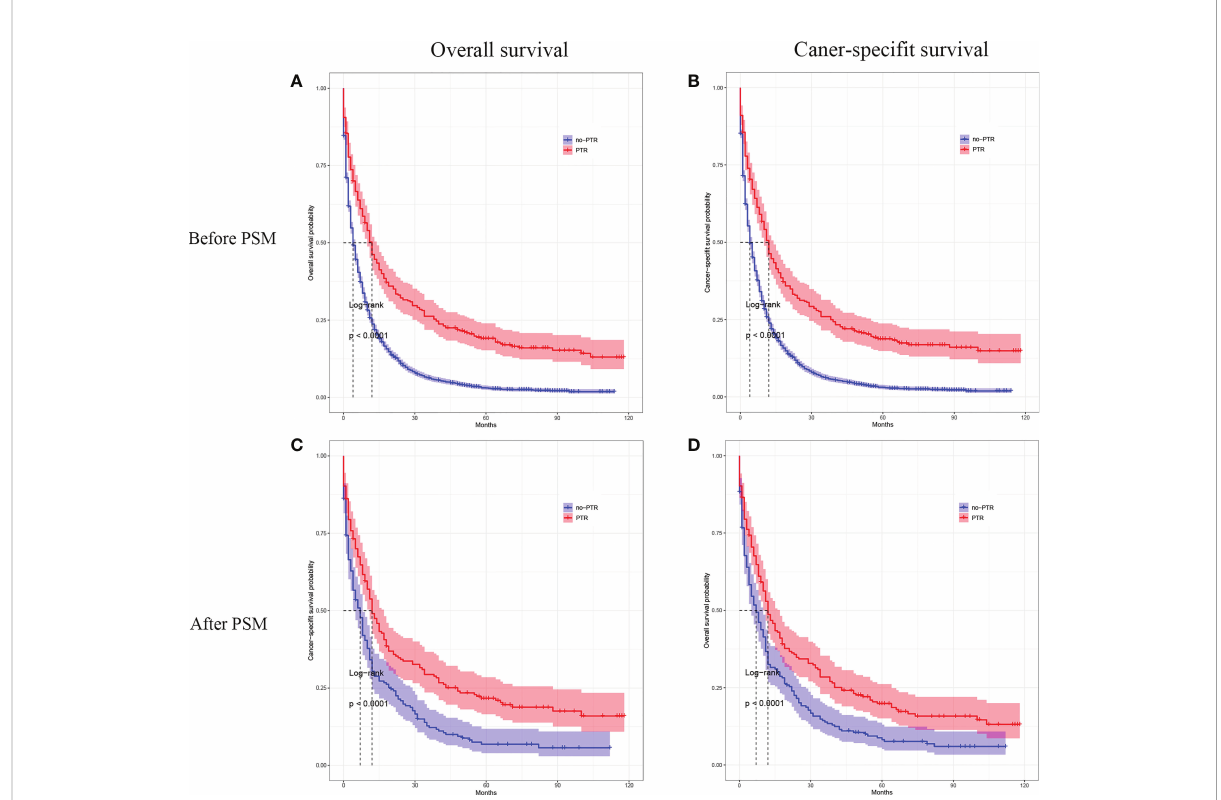
FIGURE 2 Kaplan – Meier curves for overall survival and cancer-speci fi c survival of patients with primary tumor resection versus without primary tumor resection before and after the propensity score